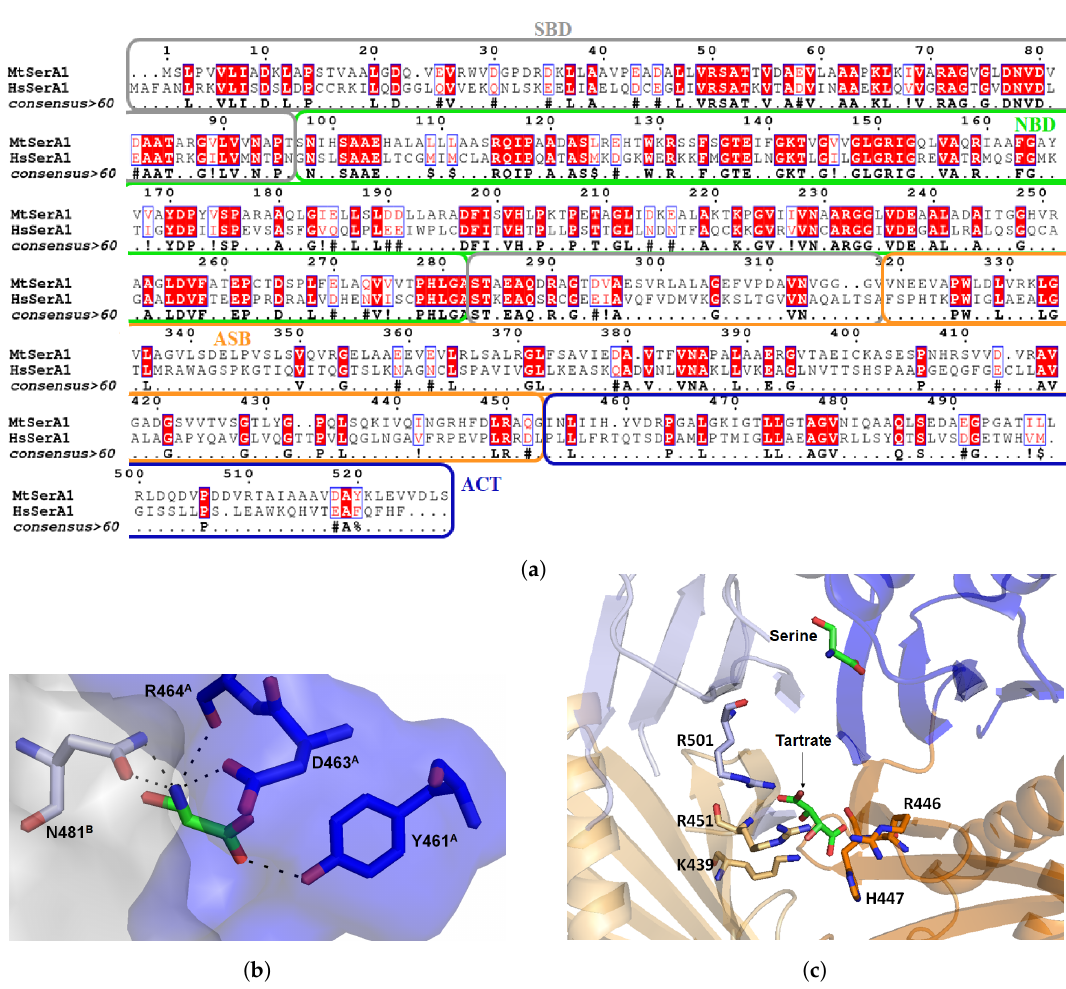
Figure 7. Sequence alignment of MtSerA1 and human PHGDH showing 33.5% overall identity and 50.7% similarity ( a ). Serine binding site within ACT domain of MtSerA1 with the ACT domain surface in blue and the one from another monomer in light grey ( b ). Anion/substrate binding site with a tartrate molecule interacting with different arginines and other positively charged amino acids ( c